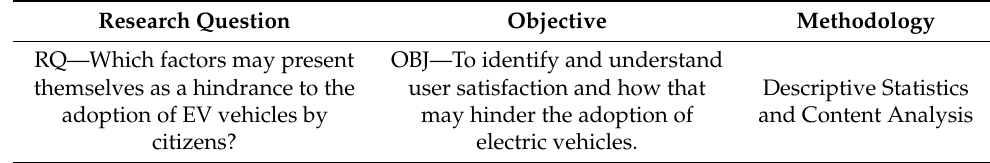
Table 1. Research question